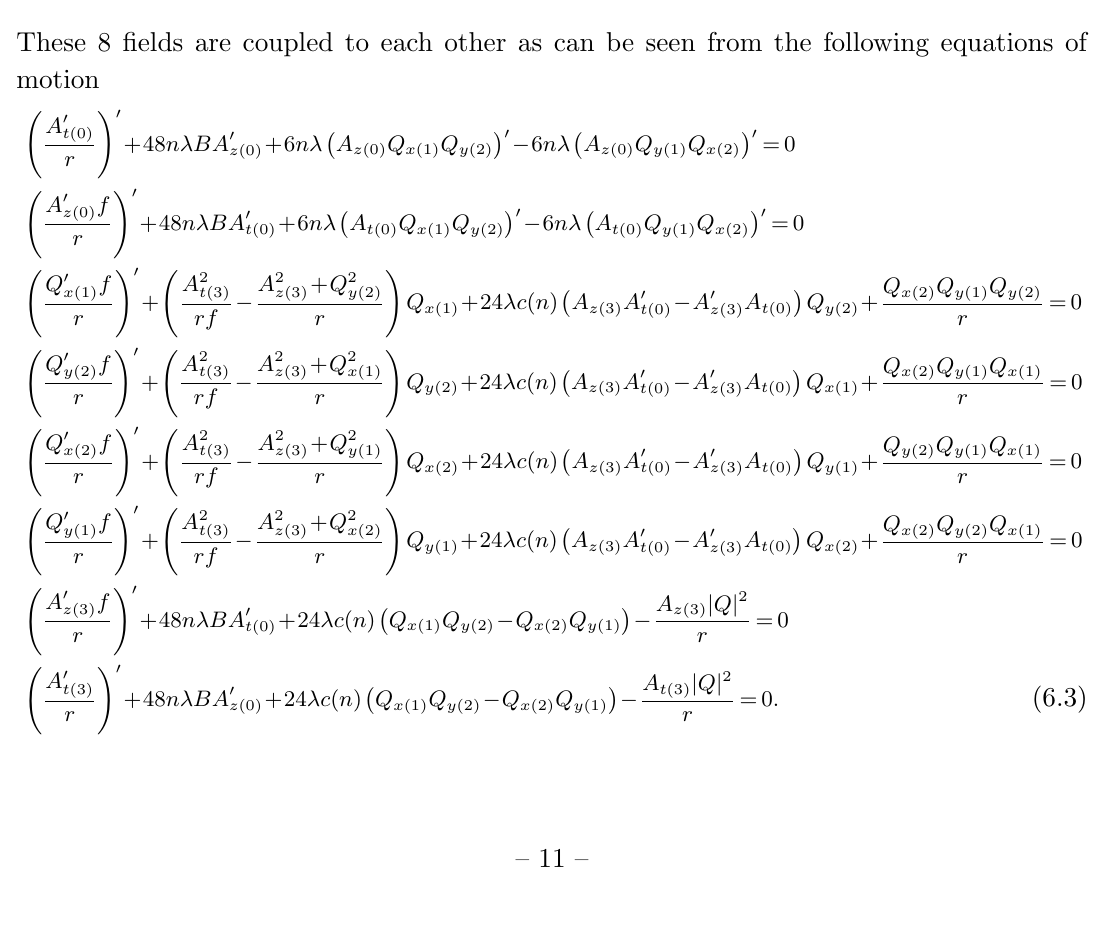
Figure 5 . Real and imaginary part of the lowest lying QNM frequencies a function of